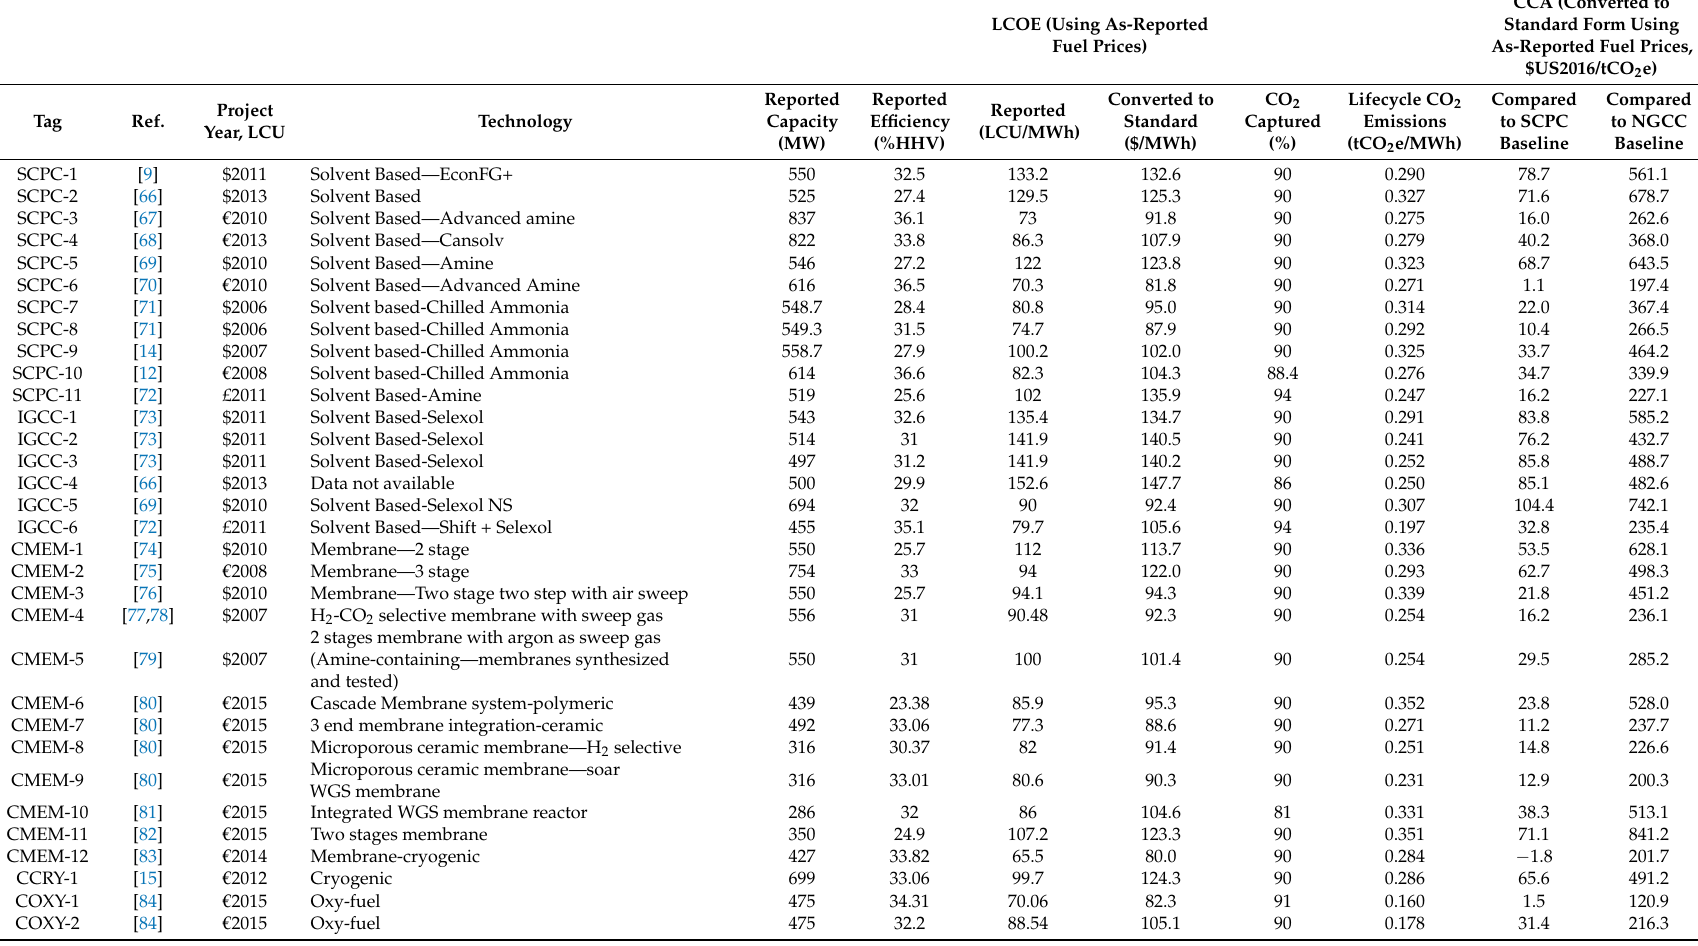
Table 2. Coal-fired power plants surveyed in the meta-study, with key metrics shown. For other metrics and intermediate calculations, please see the Microsoft Excel file included with the supplementary material. Notes: tCO 2 e is in metric tonnes. LCU = local currency unit. Converted to Standard means that the plant has been converted to the standard size, project year, and locale according to the methods described in Section